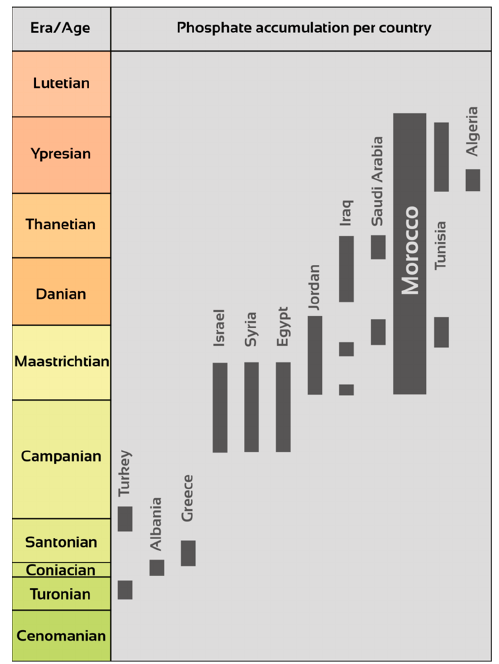
Figure 5. Stratigraphic distribution of phosphates in the Tethyan province [80].